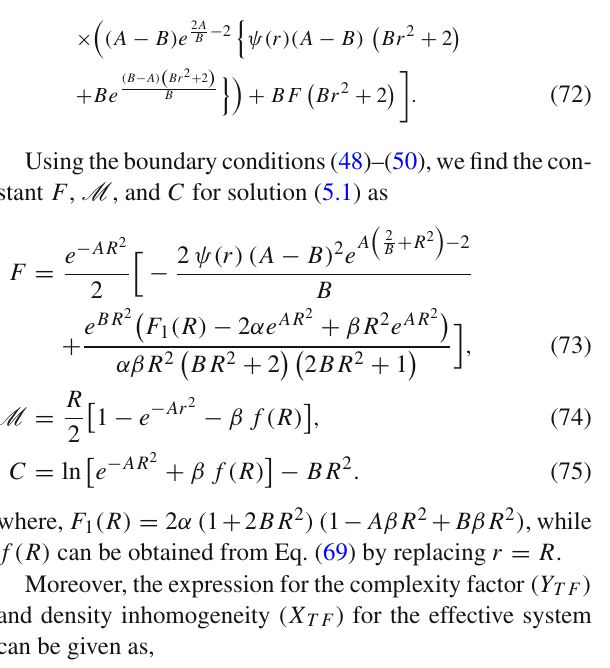
Fig. 1 Top panels : The trend of energy density ( ρ eff × 10 4 ) and radial pressure ( p eff r × 10 4 ) against the radial parameter r for different values of β . Bottom panels : The trend of tangential pressure ( p eff t × 10 4 ) and anisotropy ((cid:13) eff × 10 4 ) against radial parameter r are shown in above